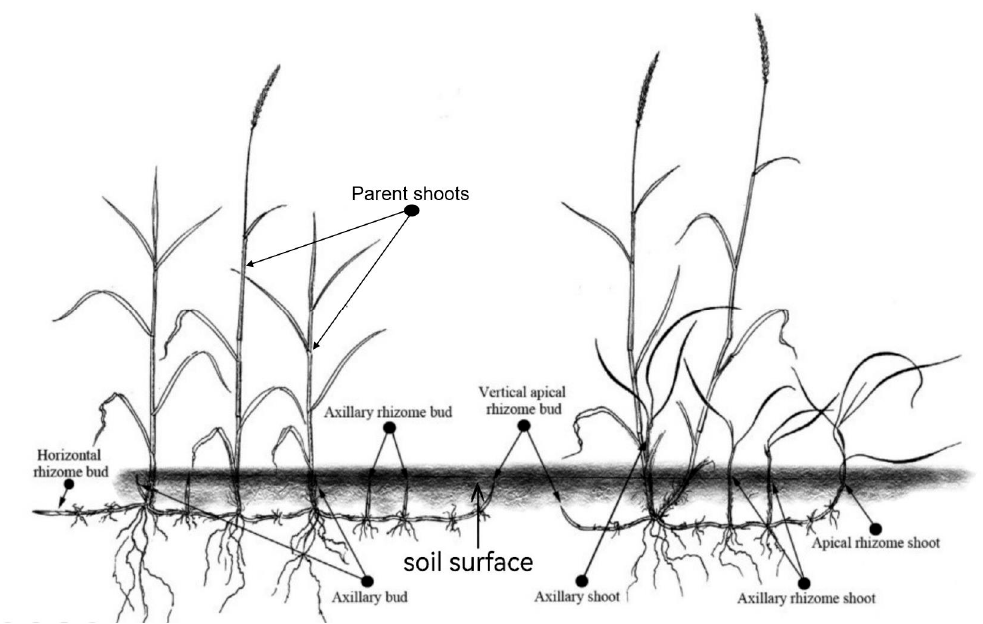
Figure 1. Plant architecture of Leymus chinensis . Shown are the various bud locations and shoots. The figure has been modified from Zhang et al. (2009)